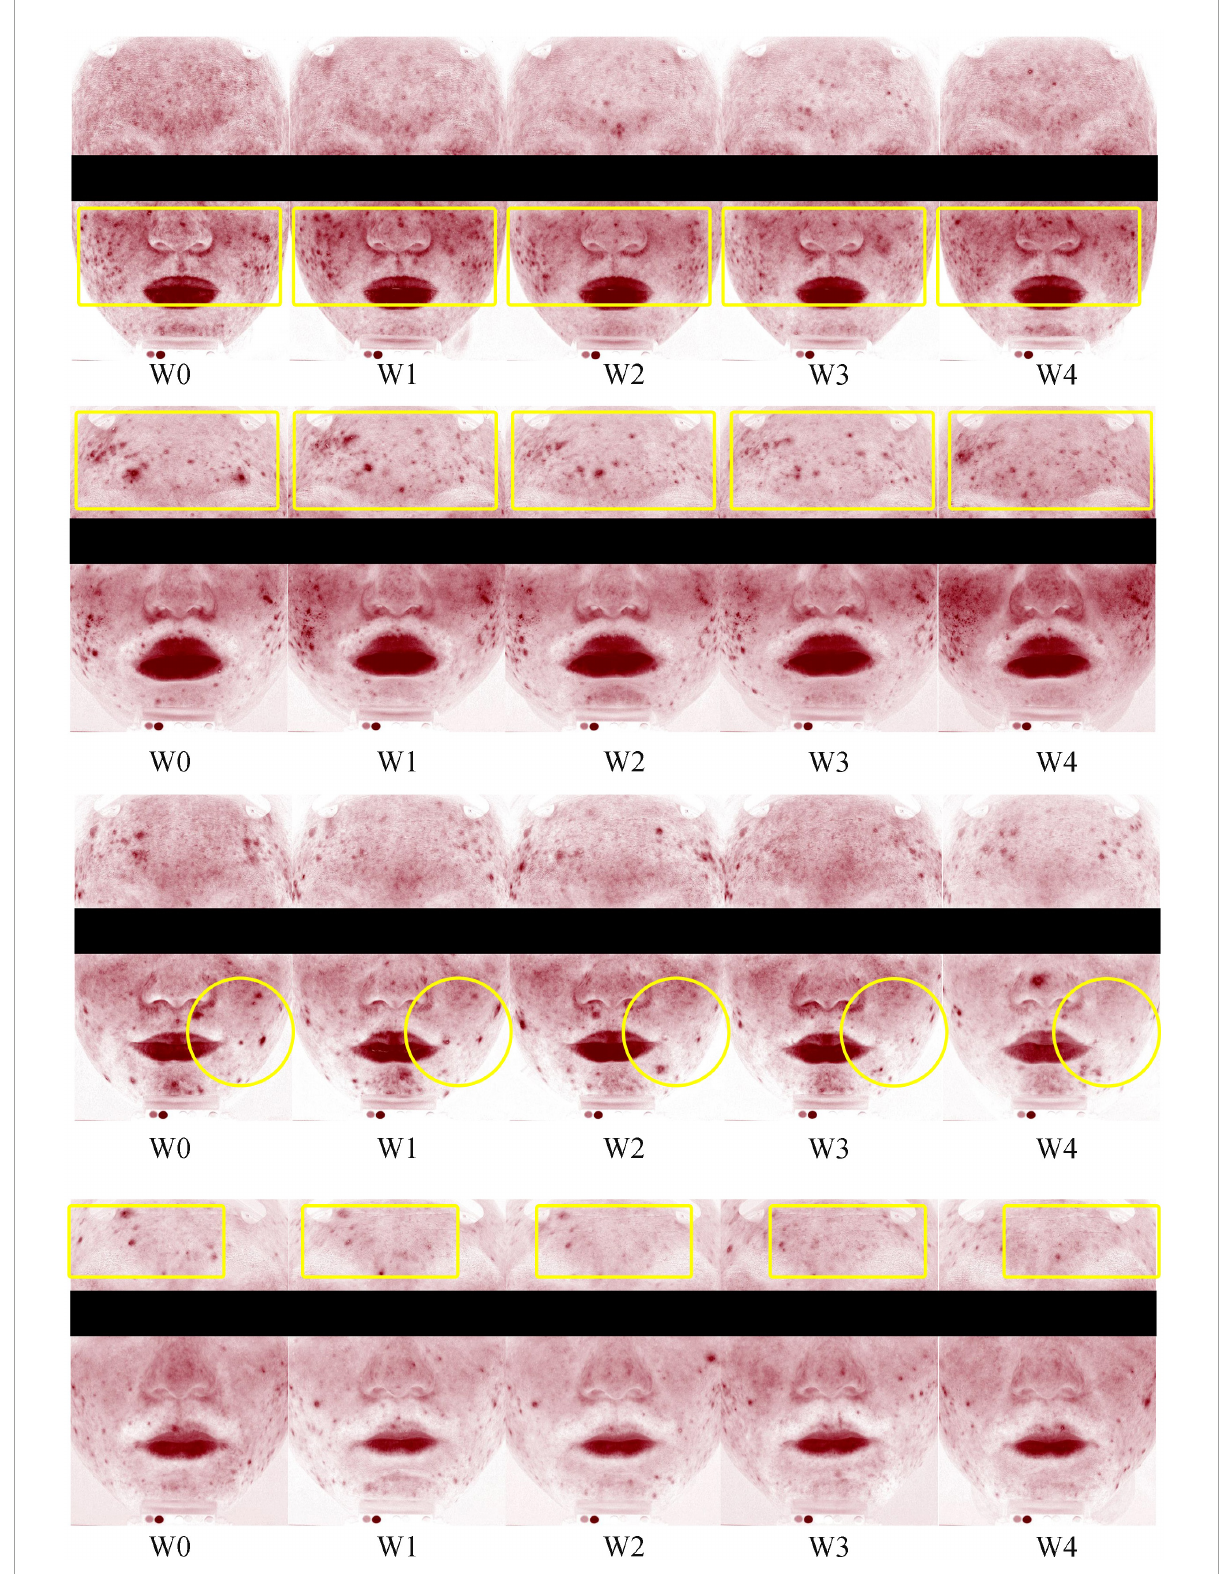
FIGURE2 Representative photographic evaluation of improvements in acne lesions at Weeks 0 (W0), 1 (W1), 2 (W2), 3 (W4), and 4